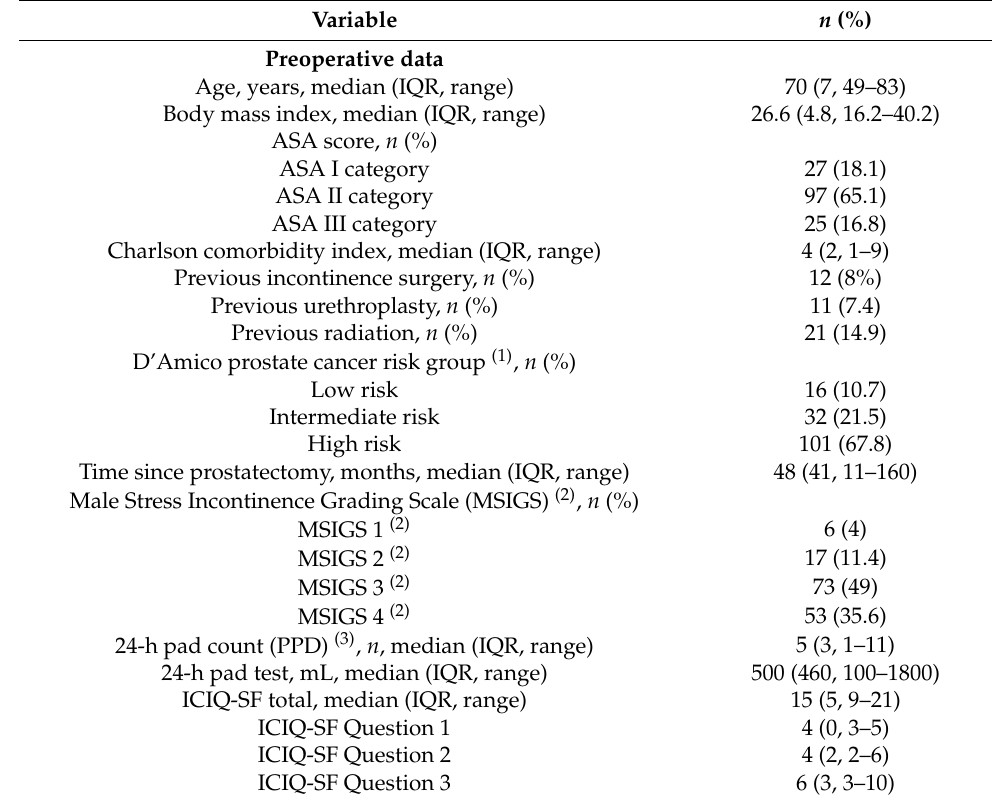
Table 1. Preoperative, operative, and postoperative data of patients included ( n = 141). Variable n